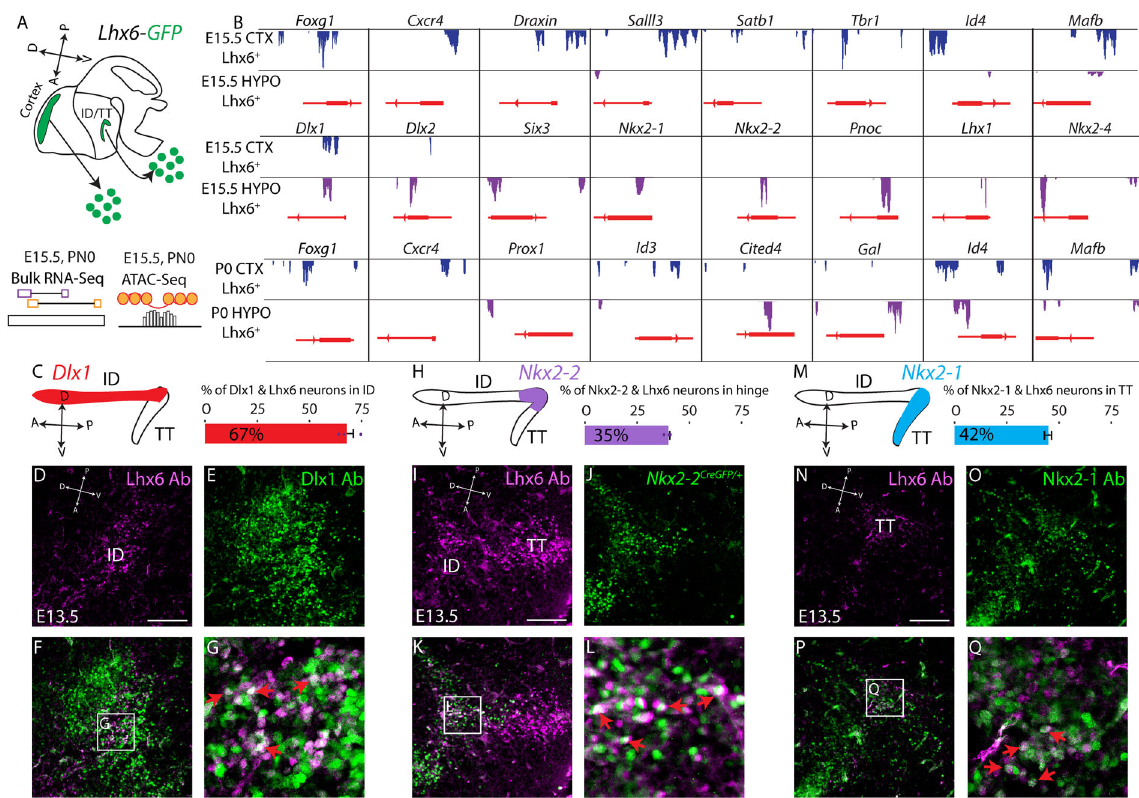
Fig. 5 Dlx1/2, Nkx2-2 , and Nkx2-1 are expressed in distinct spatial domains of hypothalamic Lhx6 neurons. A Schematic showing bulk RNA-Seq and bulk ATAC-Seq pipelines from fl ow-sorted Lhx6-GFP + neurons of the cortex and hypothalamus at E15.5 and P0. B Peaks in ATAC-Seq showing potential transcription factor binding sites near the promoter regions of differentially expressed genes from bulk RNA-Seq data in the cortex and hypothalamus at E15.5 and P0. C Schematic showing the ID/TT of the developing hypothalamus and expression of Dlx1/2 (left), and the percentage of ID Lhx6-expressing neurons that co-express Dlx1 (right). D – G Immunostaining with Lhx6 (purple) and Dlx1 (green) of E13.5 hypothalamus, showing co-localization of Lhx6 and Dlx1 in the ID of the hypothalamus ( G , red arrows). H Schematic showing ID/TT of the developing hypothalamus and expression of Nkx2-2 (left) and the percentage of hinge Lhx6-expressing neurons that co-express Nkx2-2 (right). I – L Immunostaining with Lhx6 (purple) and GFP in Nkx2-2 CreGFP/ + (green) of E13.5 hypothalamus show co-localization of Lhx6 and Nkx2-2 GFP between the ID and TT (hinge region) of the hypothalamus ( L , red arrows). M Schematic showing the ID/TT of the developing hypothalamus and expression of Nkx2-1 (left) and the percentage TT Lhx6-expressing neurons that co-express Nkx2-1 (right). N – Q Immunostaining with Lhx6 (purple) and Nkx2-1 (green) of E13.5 hypothalamus, showing co-localization of Lhx6 and Dlx1 in the ID of the hypothalamus ( Q , red arrows). Scale bar = 50 μ